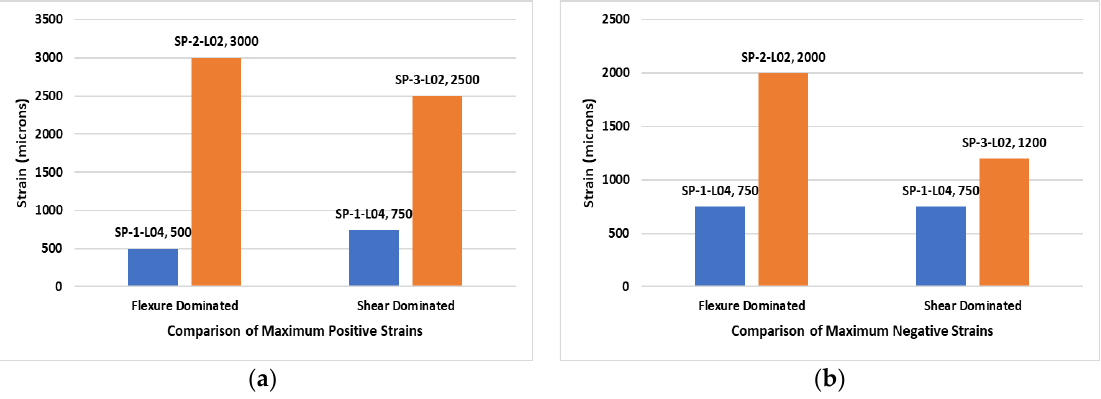
Figure 23. Comparison of strain under four-point service load ( a ) positive and ( b ) negative strain. Comparison between SP-1-L04 and SP-3-L02